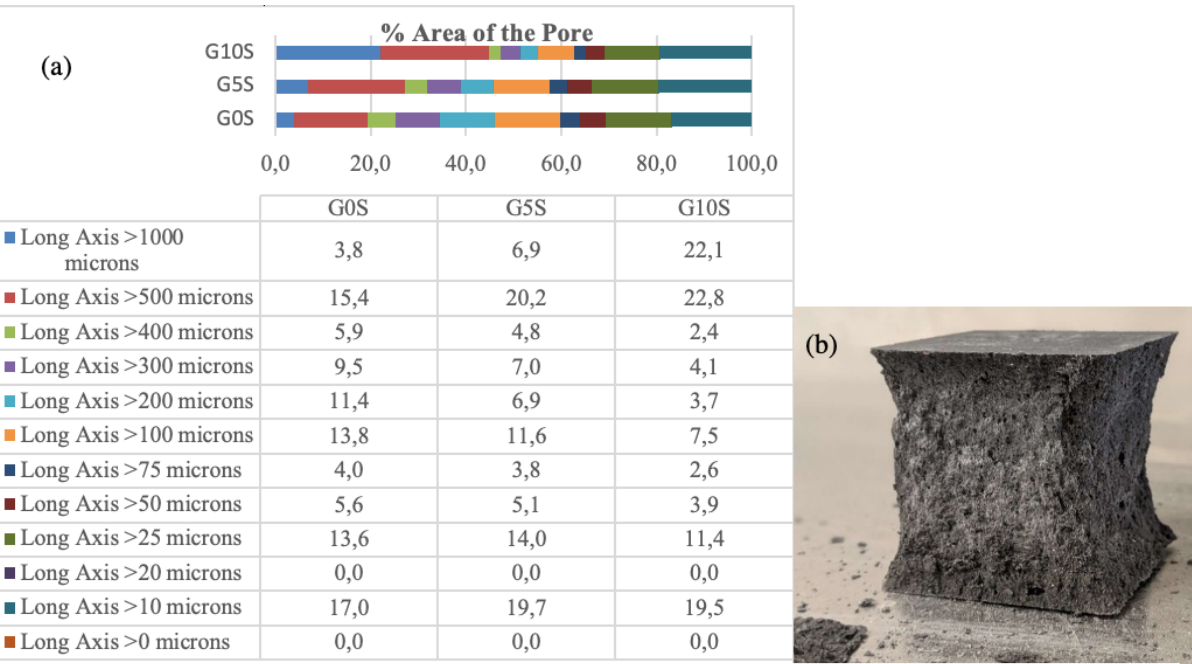
Figure 3b. The corners of the triangle correspond to 100% stoichiometric content of the main oxides, i.e., SiO 2 , Al 2 O 3 , K 2 O, Na 2 O & CaO. The sides